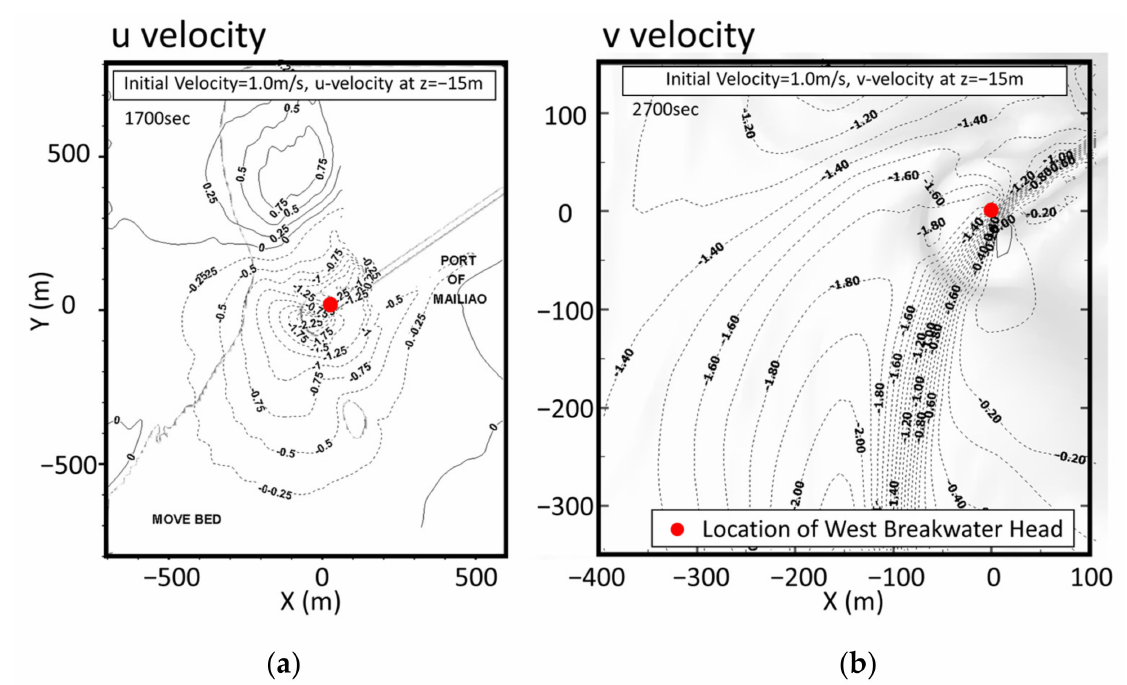
Figure 37. The u ( a ) and v ( b ) velocity fields under the action of southward current at z = − 15 m.